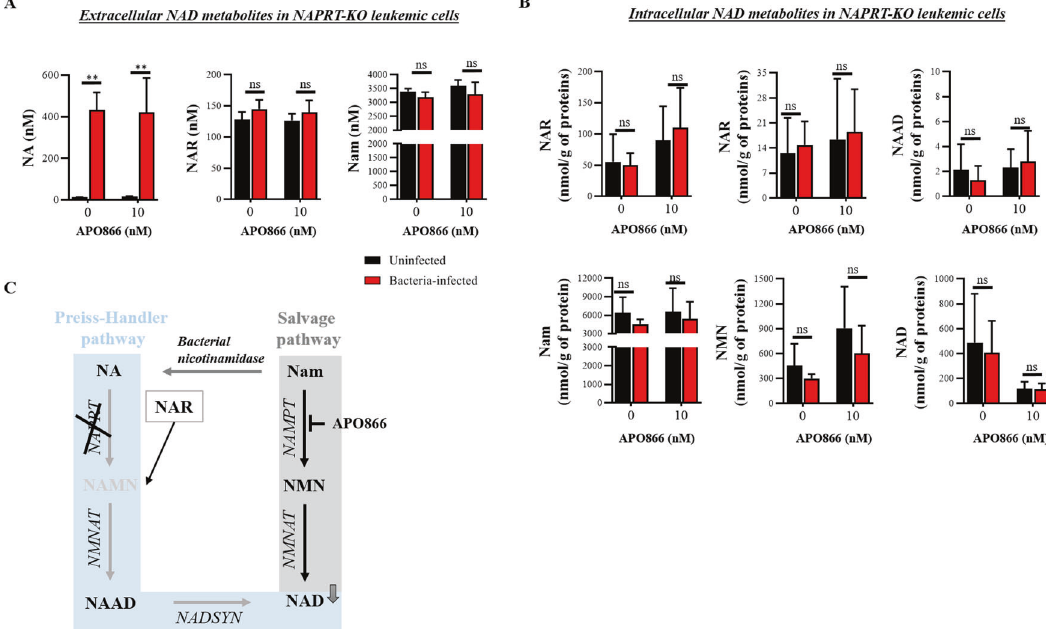
Fig. 5 Bacteria-infected NAPRT-KO leukemic cells do not lead to activation of the Preiss-Handler pathway despite the signi fi cant increase of NA in the conditioned medium. Quanti fi cation of extracellular ( A ) or intracellular ( B ) NAD + metabolites in cell-conditioned medium or within cells from uninfected or bacteria-infected NAPRT-KO ML-2 cells, using LC-MS/MS. C Summary of identi fi ed NAD + metabolites: in red, metabolites signi fi cantly increased; black, no changes; and grey, metabolites not detected (below the limit of detection). Data are derived from at least three independent experiments. Data are mean ± SD, ** p < 0.01, ns not signi fi cant.